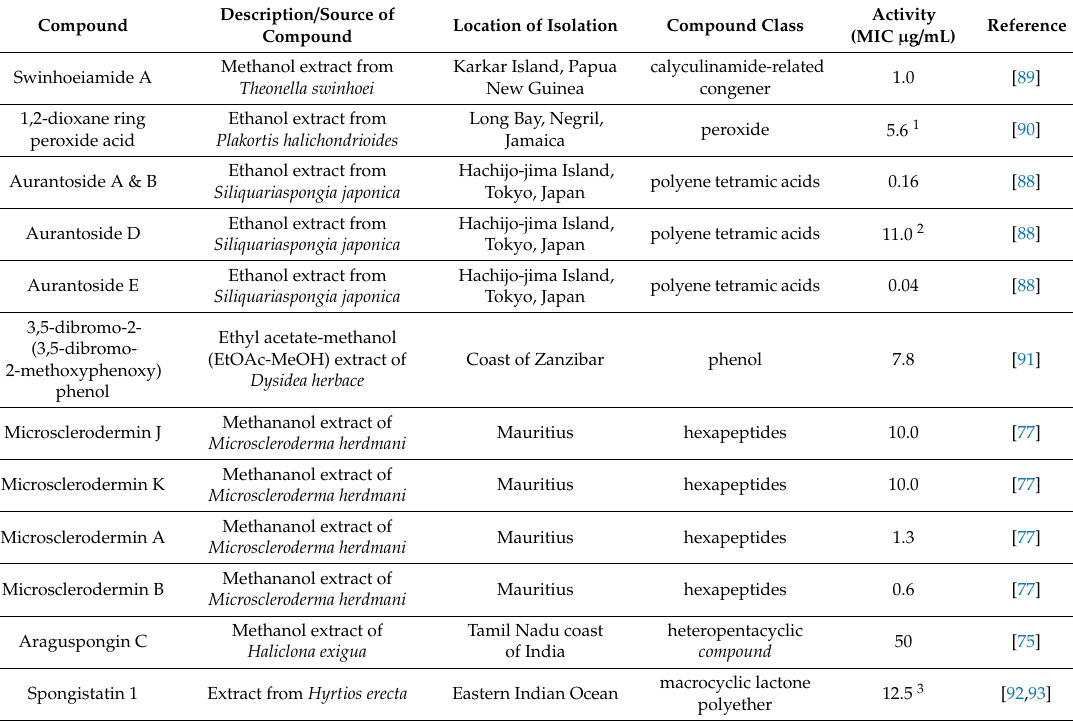
Table 3. E ff ective compounds against A. fumigatus from marine sponges.